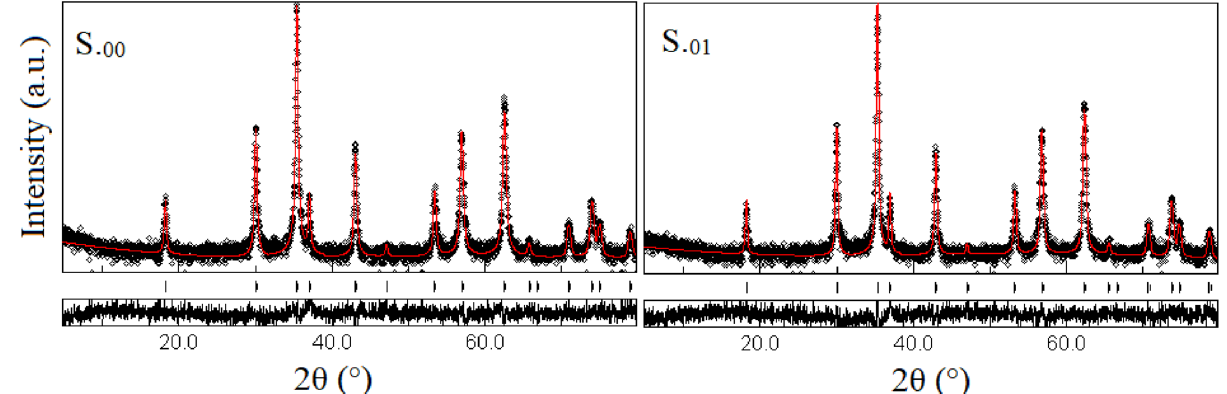
Figure 5. The Rietveld-refined XRD patterns of as-prepared specimens as marked on the patterns.